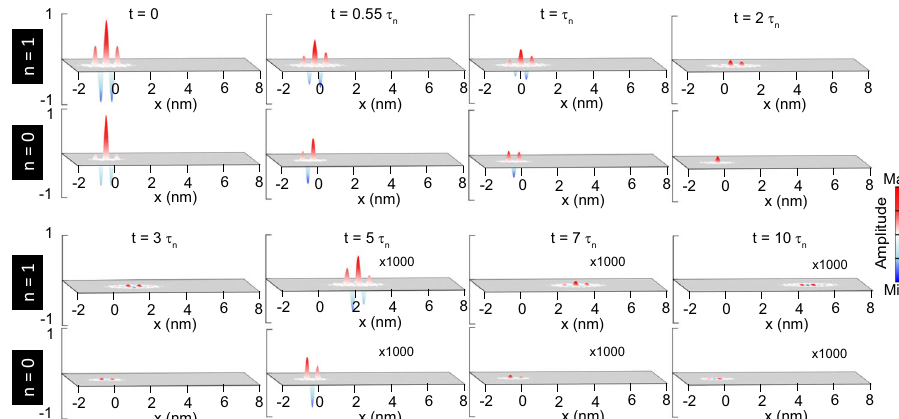
Fig. 6 Real-space evolution of surface and interface magnons in the Co/Co/Fe structure. The evolution of the magnon wave packets in the Co/Co/Fe structure at the point ( q x , q y ) = (0.71, 0.71), indicated in Fig. 5. Here, q x and q y represent the x and y components of the wavevector. τ n denotes the lifetime of the n th magnon mode and is obtained from the experimental data ( τ n = 2 _ = Γ n , where Γ n represent the intrinsic broadening of the magnon modes, τ 0 = 33 fs and τ 1 = 15 fs). The amplitude of the wave packets after t = 5 τ n is multiplied by 1000 for clarity. The n = 0 mode does not propagate, indicating its standing-wave characteristics, while the n = 1 mode propagates over 5 nm within t = 150